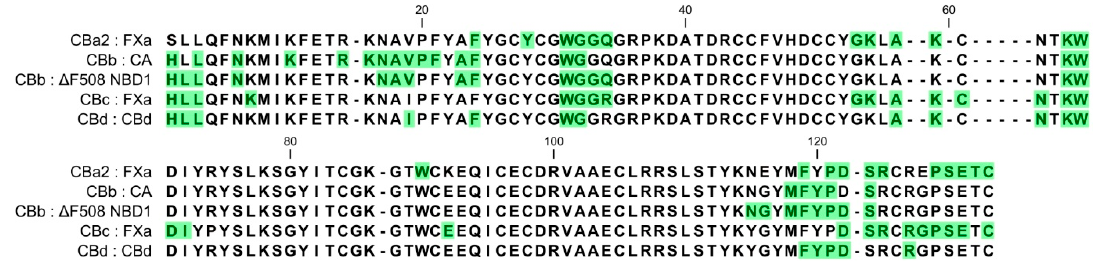
Figure 5. Sequences of CB isoforms showing the key residues in the interface regions of the specified complexes. Green-shadowed characters denote residues at the interface of CBa 2 /hFXa [19], CBb/CA [27], CBb/ Δ F508-NBD1 [20] of CFTR, CBc/hFXa [19], and CBd/CBd [this study].